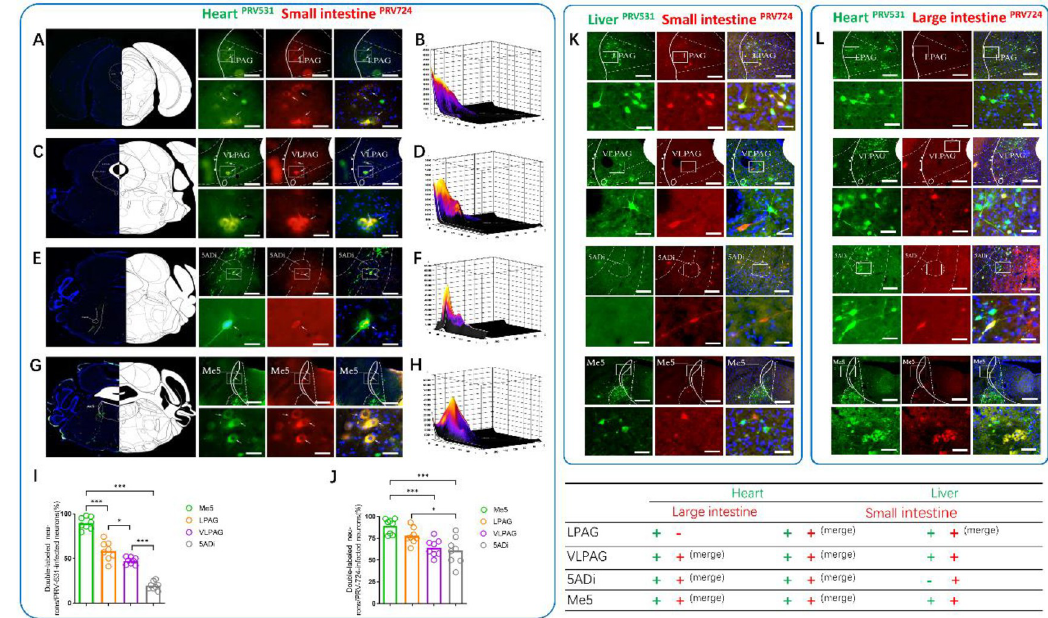
Fig 4. The common output of the whole-brain to small intestine and heart. A/C/E/G) Upper, Heart (green) neurons co-labeled with Small intestine (red) in the LPAG/VLPAG/5Adi/Me5 (scale bar, 100 um). Lower, magnification images of the area outlined by the white box (scale bar, 25 um). B/D/F/H) Colocalization analysis of neurons co-labeled in LPAG/VLPAG/5Adi/Me5. I) Analysis of co-localized neurons (double-labeled neurons/PRV-531 infected neurons). J) Analysis of co-localized neurons (double- labeled neurons/PRV-724 infected neuron). K) Upper, Liver (green) neurons co-labeled with Small intestine (red) in the LPAG/ VLPAG/5Adi/Me5 (scale bar, 100 um). Lower, magnification images of the area outlined by the white box (scale bar, 25 um). L) Upper, Heart (green) neurons co-labeled with Large intestine (red) in the LPAG/VLPAG/5Adi/Me5 (scale bar, 100 um). Lower, magnification images of the area outlined by the white box (scale bar, 25 um). The white arrows show the neural of colocalization fluorescence labeling; yellow fluorescence shows colocalization of green and red fluorescence; LPAG, lateral periaqueductal gray; VLPAG, ventrolateral periaqueductal gray; 5Adi, motor trigeminal nucleus anterior digastric Part; Me5, mesencephalic trigeminal nucleus. All data are presented as the mean ± SEM. ��� P < 0.001, �� P < 0.01, � P <